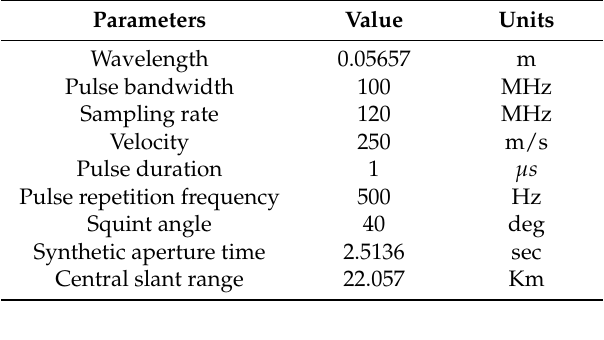
Table 1. Simulation parameters.